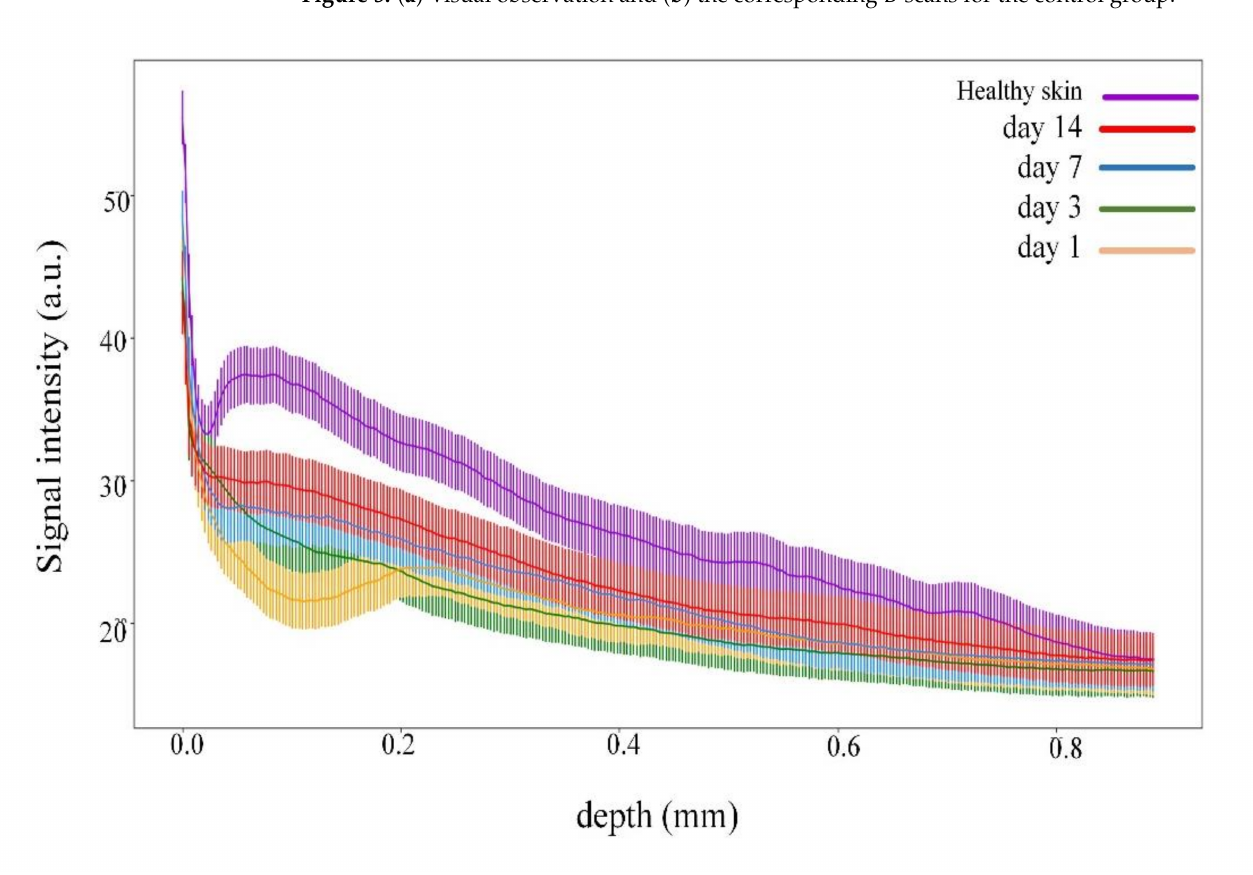
Figure 5. ( a ) Visual observation and ( b ) the corresponding B-scans for the control group.